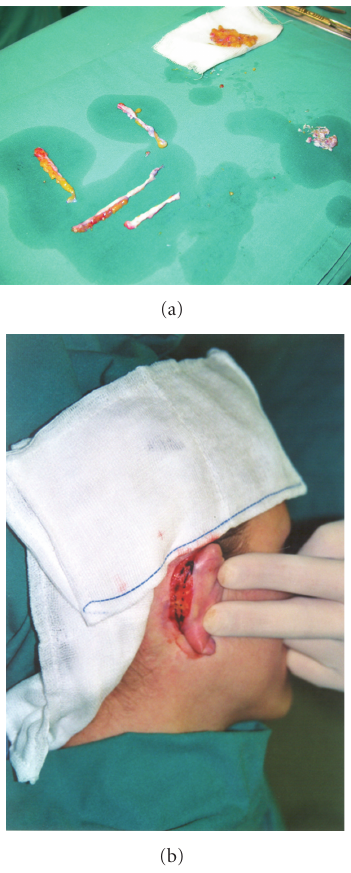
Figure 1: (a) Graft prepared and ready to be inserted during a tight lift, (b) available and utilizable tissue during an otoplasty operation.